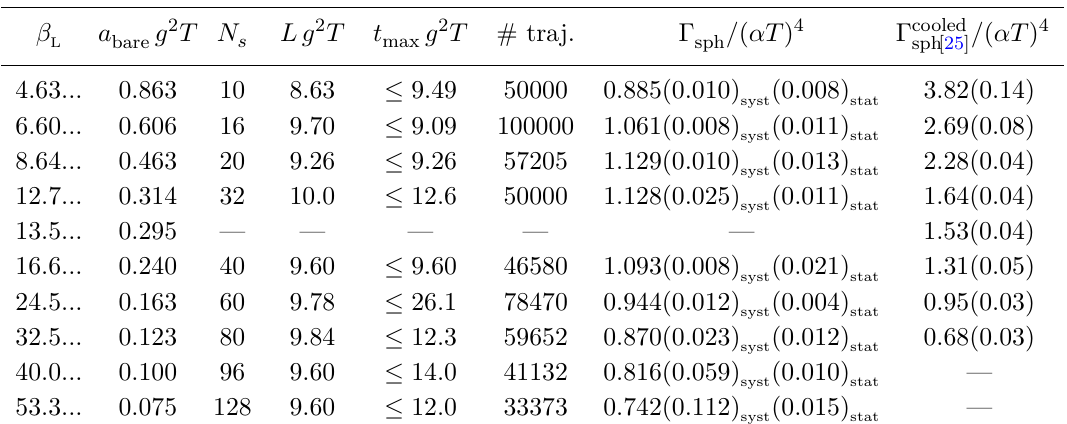
Table 1 . Our results for the sphaleron rate for N = 2 , compared with “cooled” rates from table 2 c of ref. [25], however we have undone the improvement employed in the latter study, by making use of eq. (5.2). The values of a g 2 T are treated as “exact”, whereas digits have been truncated from bare the values of β shown (cf. eq. (5.3)). These results are illustrated in figure 3. L whereas the variation ¯ θ = 5 − 8 (4 − 6) for N = 2 (3) has been employed for estimating c the systematic uncertainty of this procedure. The final statistical error is the average of the jackknife errors from all values of ¯ θ considered. In tables 1 and 2, the systematic and statistical uncertainties are displayed separately, whereas in figure 3, they have been combined in